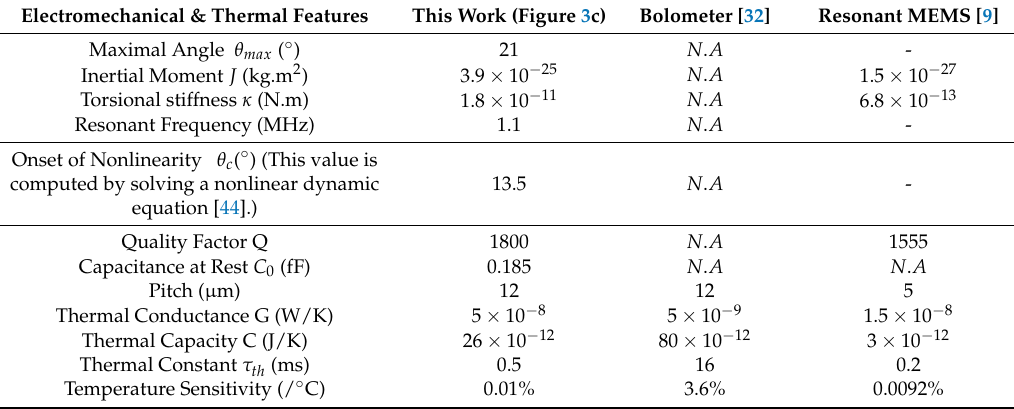
Table 1. Key parameters presented in the Equations (1)–(5) for our device compared with an advanced resistive bolometer and microelectromechanical systems (MEMS) bolometer: temperature sensitivity × ∂ f ∂ T for a resonant thermal sensor and 1 corresponds to 1 f Electromechanical & Thermal Features